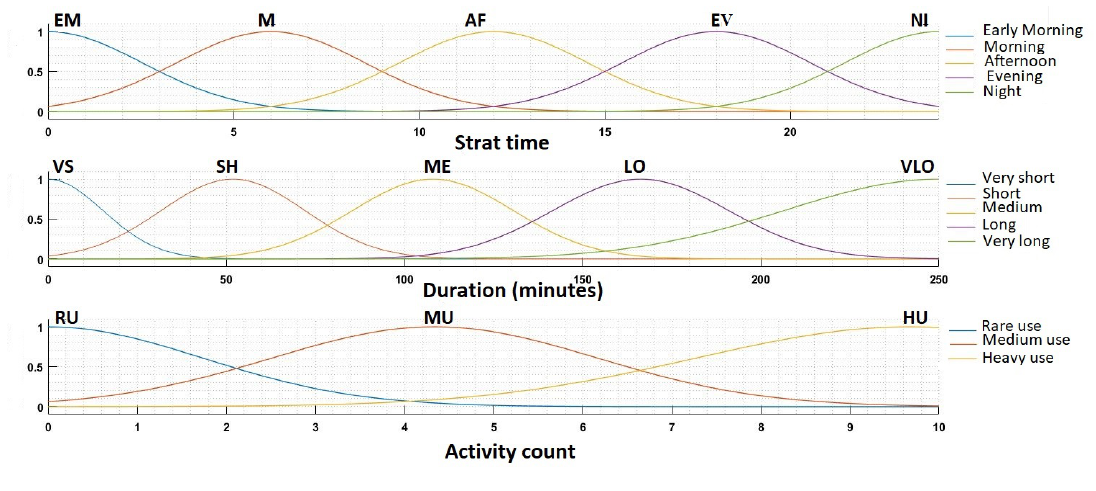
Figure 6. Fuzzy membership functions representing input